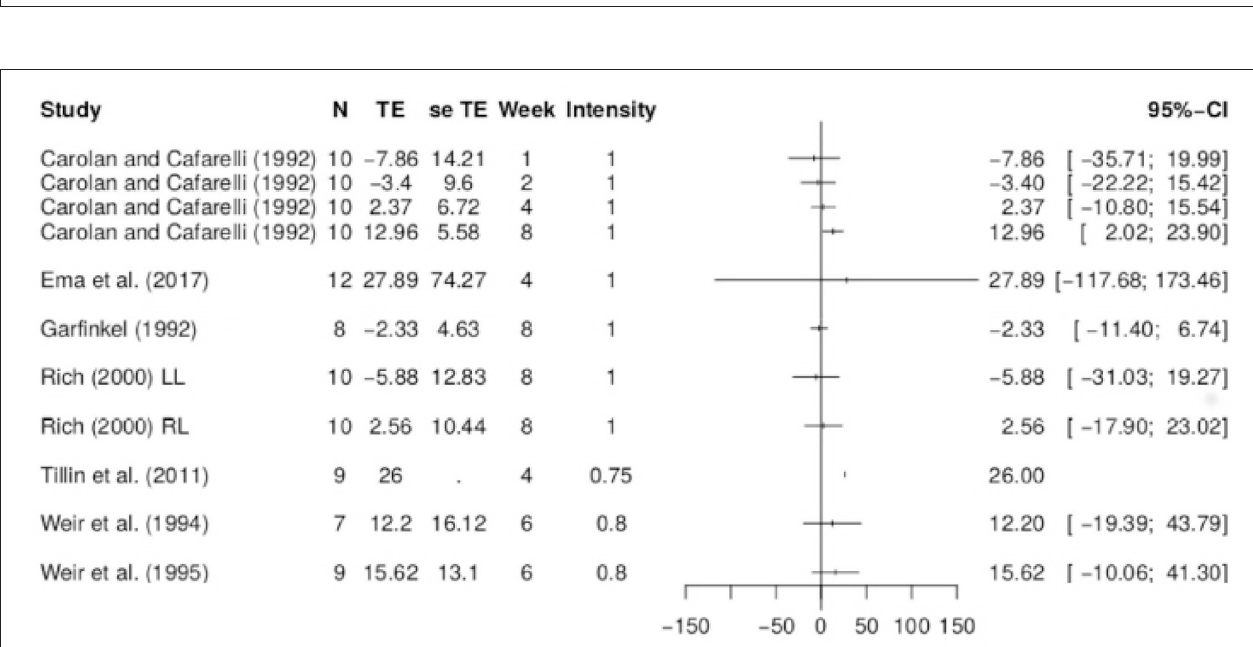
FIGURE 5 | Forest plot for the data on EMG. Here N denotes the number of subjects, TE and se TE denote the mean and standard deviation of the treatment effect, week denotes the time point and intensity denotes the training intensity. A training intensity of 1 corresponds to 100% MVC.